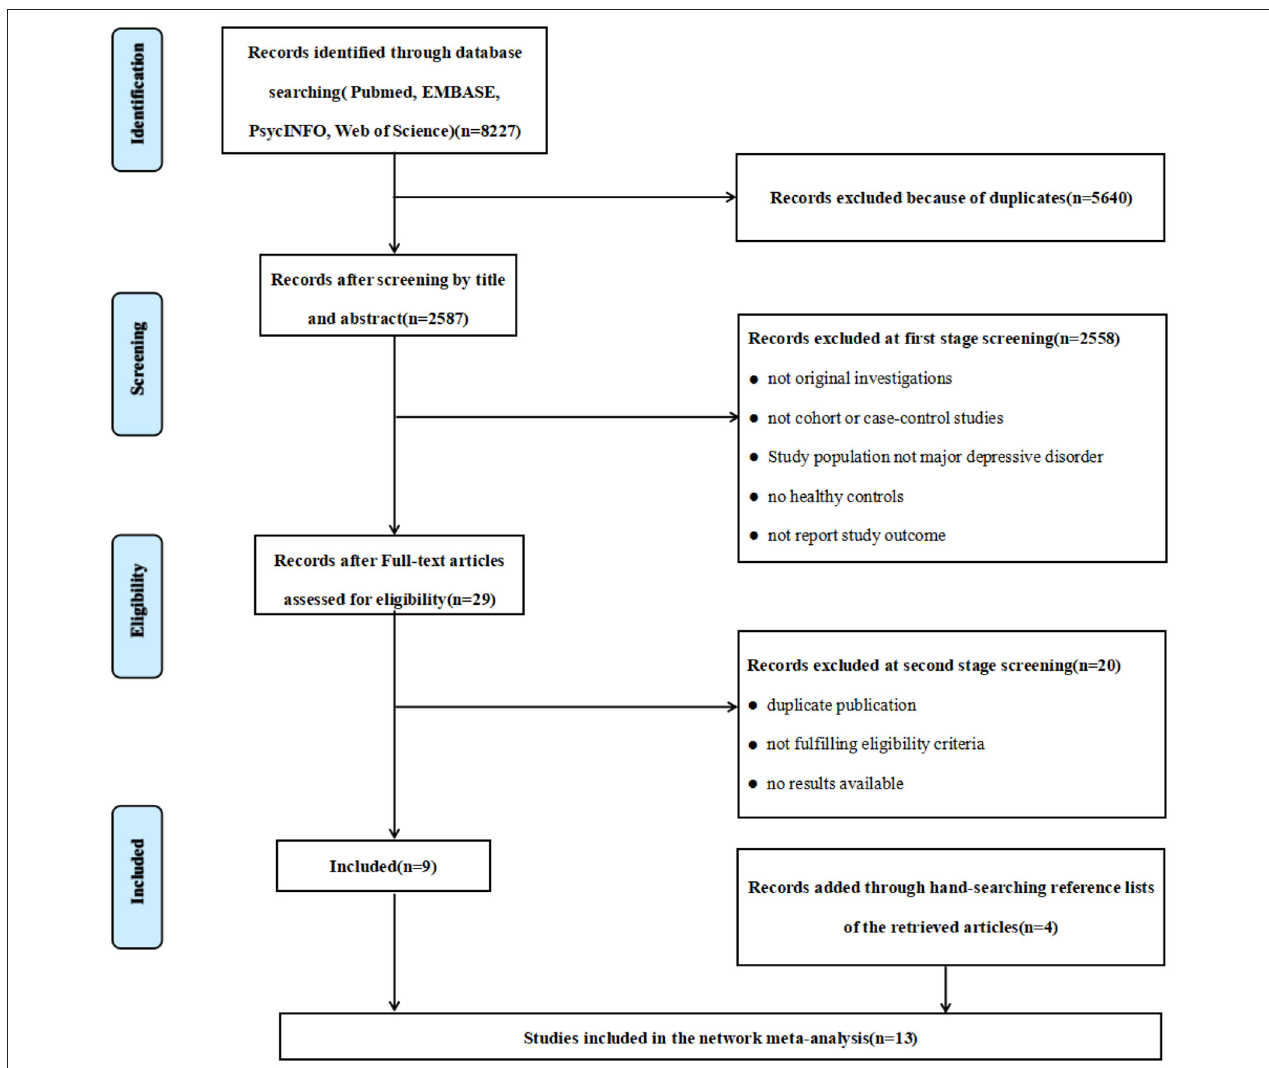
FIGURE 1 | PRISMA flow diagram of study selection